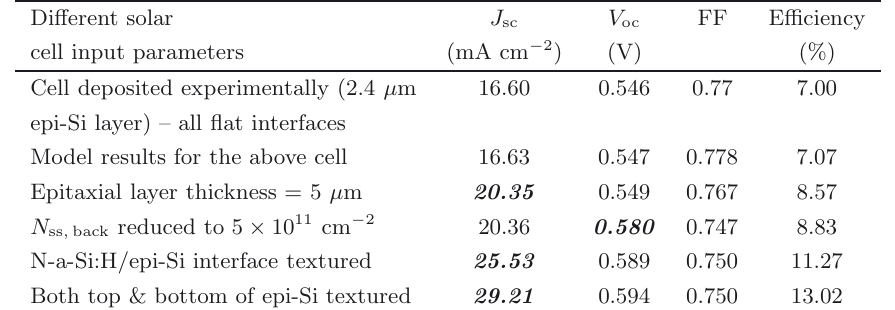
Table 5. Cumulative improvement of the solar cell output parameters by improving various device and material parameters. The parameter that is improved at each stage leading to a higher efficiency, is given in bold